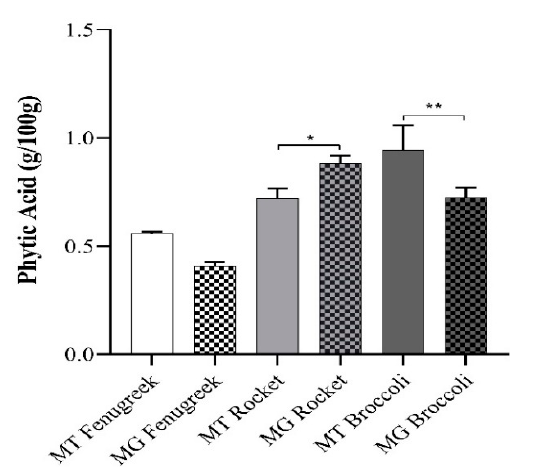
Figure 4. Phytic acid content (g / 100 g) of the vegetable samples. Values are presented as means ± SEM, n = 6. Comparison of means of microgreens and mature vegetables were analysed using an independent samples t-test. The di ff erences between the groups are denoted: * ( p ≤ 0.05) and ** ( p ≤